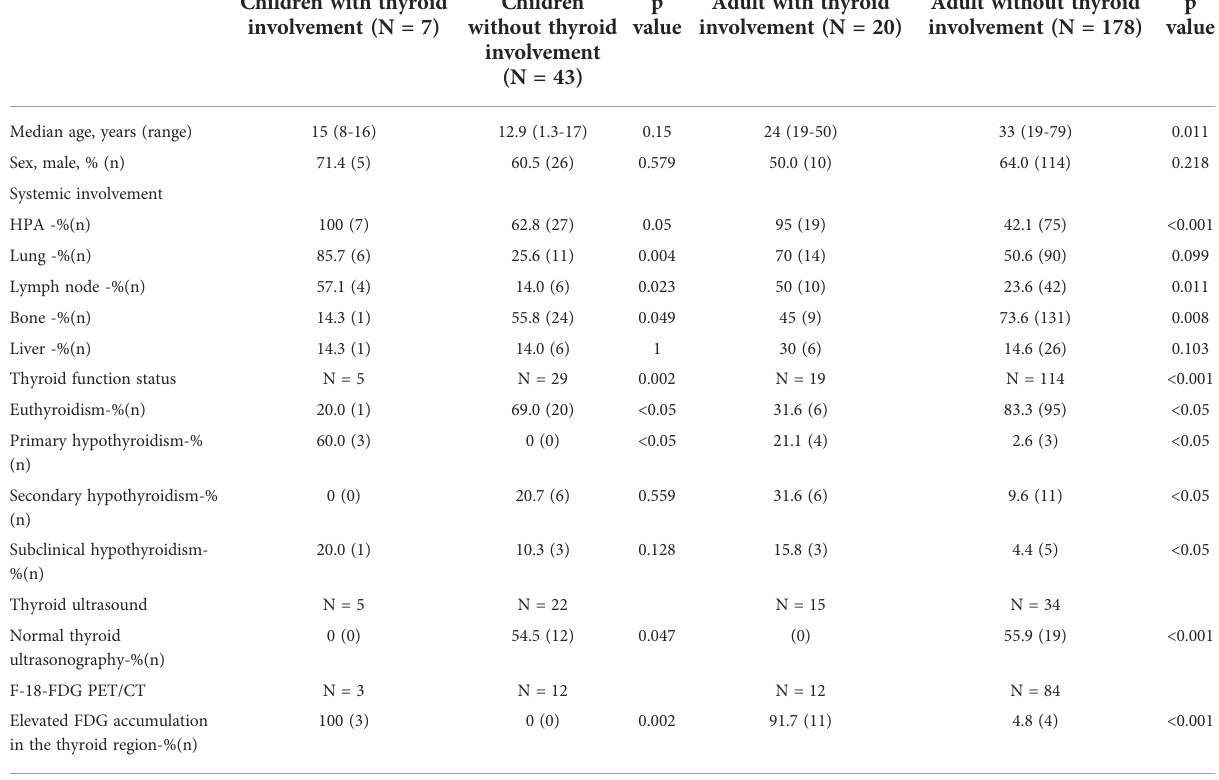
TABLE 2 Characteristics of LCH patients with and without thyroid